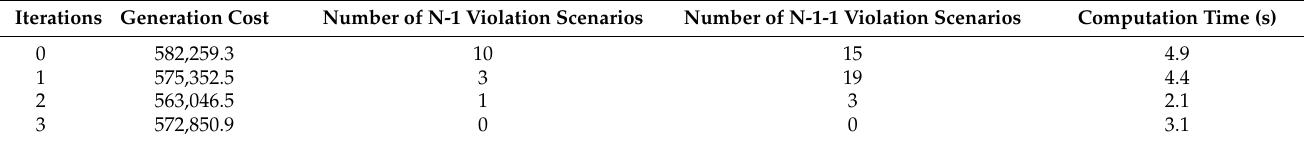
Table 4. Results of the iterative contingency filtering process of the SCAPD model tested on the IEEE 118-bus system.